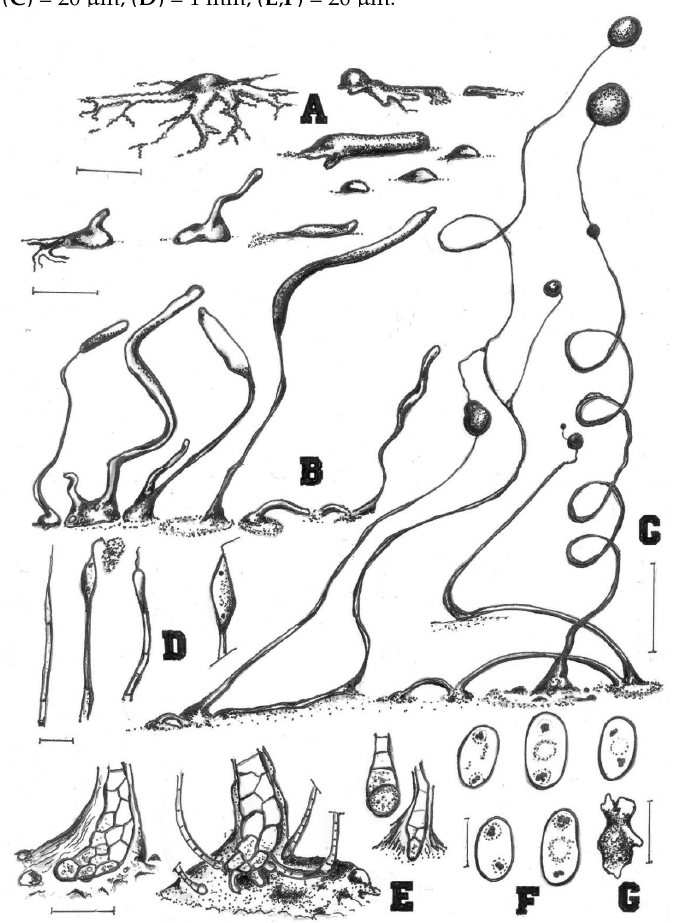
Figure 2. Morphological features of Cavenderia helicoidea (TH19B). ( A ), Medium-sized streamed ag- gregation, with edges (left) and the most common type consisting of small mounds, some with short blocky streams (right). ( B ), Early central sorogen (above, left); these settle without streams (above, center) and migrate with short stalk formation; small mounds, unstreamed (above, right); Group of solitary (below left and center) and tightly clustered sorogens (below center); the stoloniferous mi- grating habit of a late sorogen (below, right). ( C ), Clustered sorocarps, one with a prostrate lower stalk (left); two solitary sorocarps, one with a typical stoloniferous habit and the other with its fre- quent helical architecture; two sori are tangled, one small example refruits, and small mounds are present within the halo at bases (right). ( D ), Four simple tips, mostly piliform, and one ampule- shaped, a mass of dense slime attached to a filament. ( E ), Curved clavate base with flexuous small cells, except the terminal one (left); a curved base with small satellite sorocarps and some digitate cells, within a dense matrix of slime (center, aged culture); a one-celled round base and a clavate